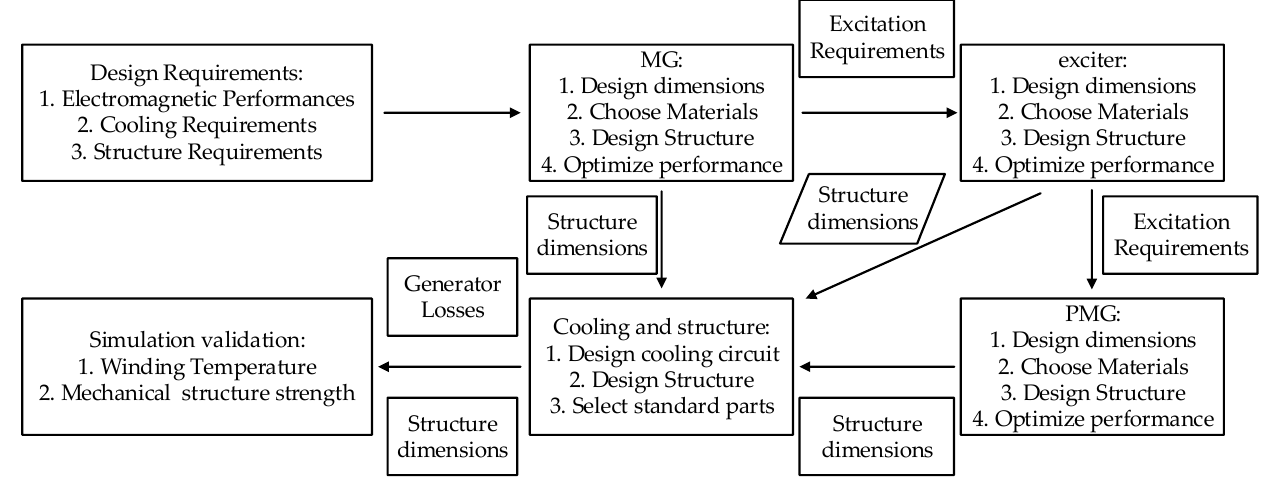
Figure 2. The flow chart of the BSG design process.